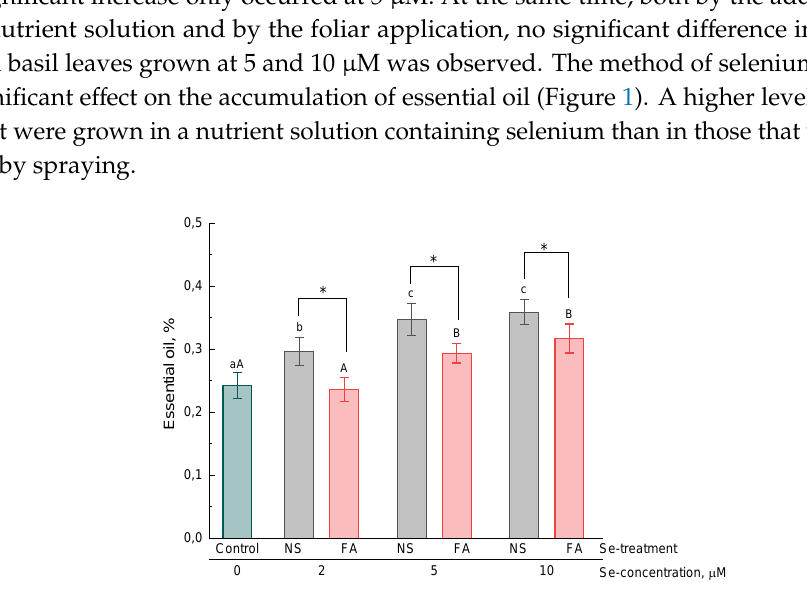
Figure 1. E ff ect of type and concentration of Se application on the essential oil content in basil leaves.